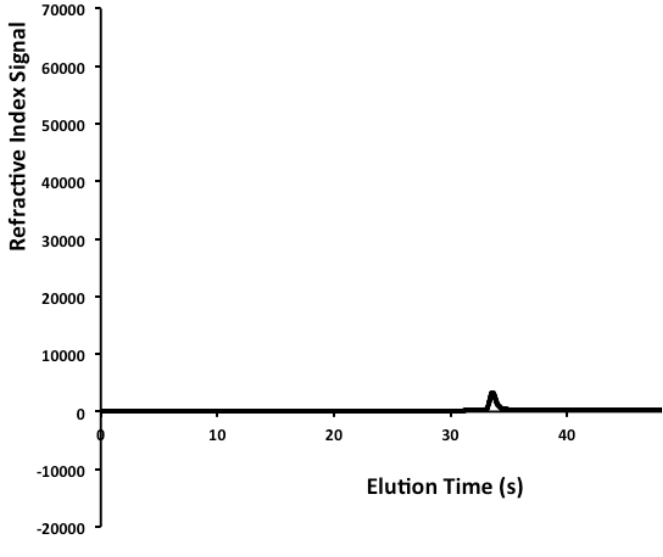
Figure 2. GPC result of compound 3 .